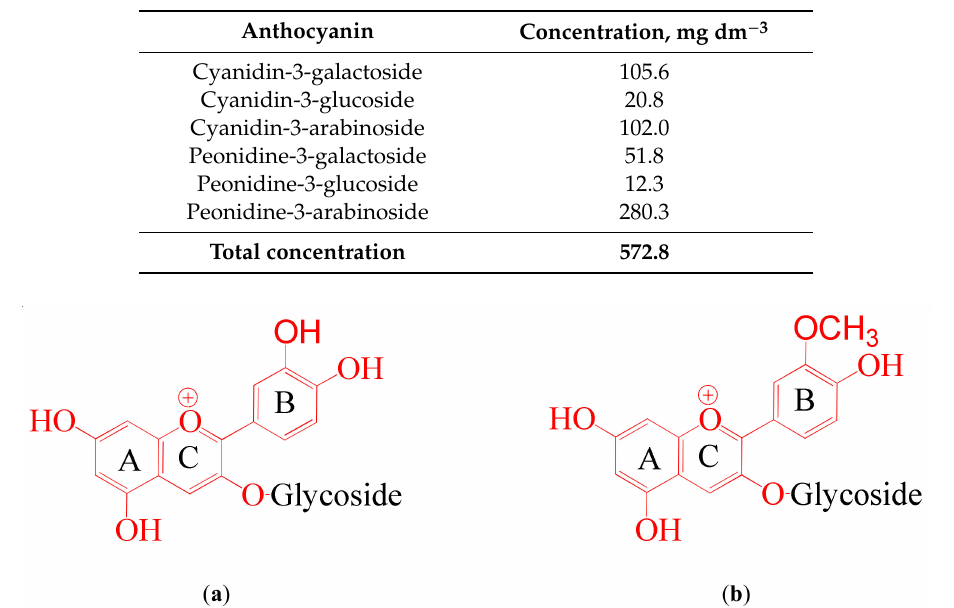
Table 1. Composition of the anthocyanin extract from grape pulp.